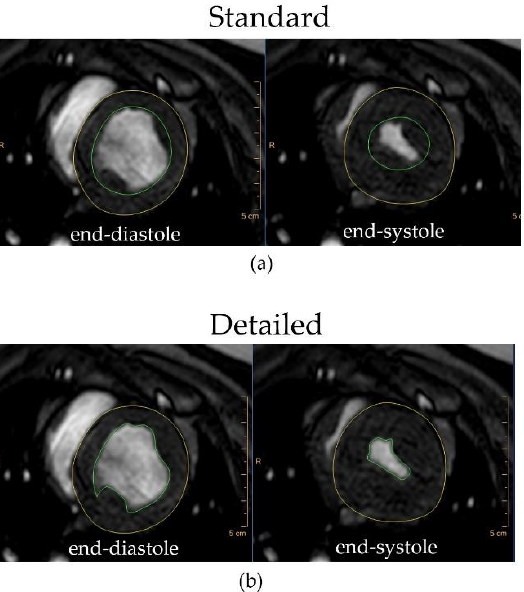
Figure 2. Examples of the standard ( a ) and detailed ( b ) tracing methods of the normal Yucatan minipig heart at the end-systolic and end-diastolic phases of the cardiac